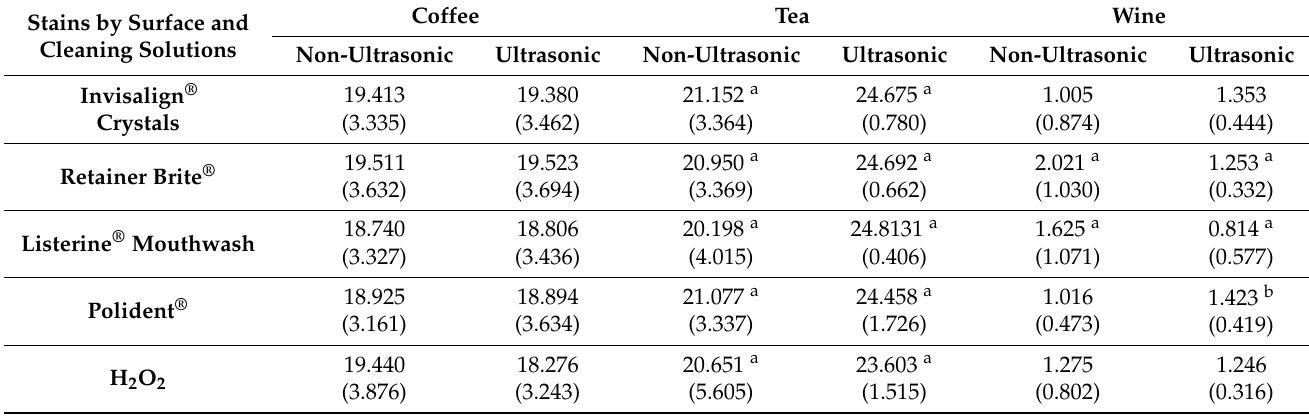
Table 7. Changes in percent light transmittance, ∆ T, of copolyester retainer specimens stained in coffee and tea solutions and then destained with five different cleaning solutions with or without the use of an ultrasonic cleaner unit (mean ∆ T value in % ± standard